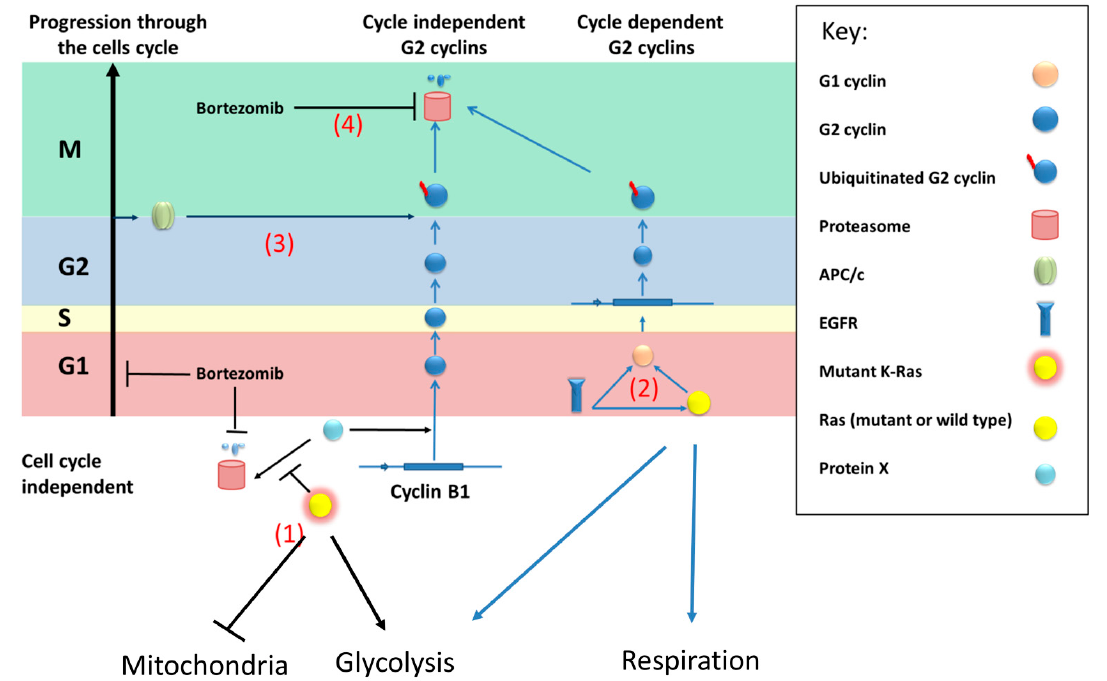
Figure 7. Model of a compensatory mechanism of wild-type Ras expression in cells with mutant K-Ras: (1) Mutant K-Ras causes reduced mitochondrial activity (possibly by reducing the number of mitochondria) and promotes the production of G2 cyclins by inhibition of the proteolysis of an unknown transcriptional activator (x) of cyclin B1. (2) Wild-type (or mutant) Ras will increase transcription of G2 cyclins via G1 cyclins in a cell cycle-dependent fashion. EGFR can activate this process but can also increase G1 cyclins by directly binding to their promoters, compensating for the non-cyclic levels linked to the mutant protein. Furthermore, based on results from N-Ras knockdown, the wild type (N-Ras) increases glycolysis and the efficiency of respiration. (3) G2 cyclins will be degraded via the APC/c complex, therefore, in the absence of mutant Ras, the level of the G2 cyclins will be limited by the proportion of cells in G2. (4) Bortezomib inhibits the proteasome, causing stabilisation of ubiquitinated G2 cyclins, reducing the production of ubiquitinated protein by restricting entry to (and exit from) G2.